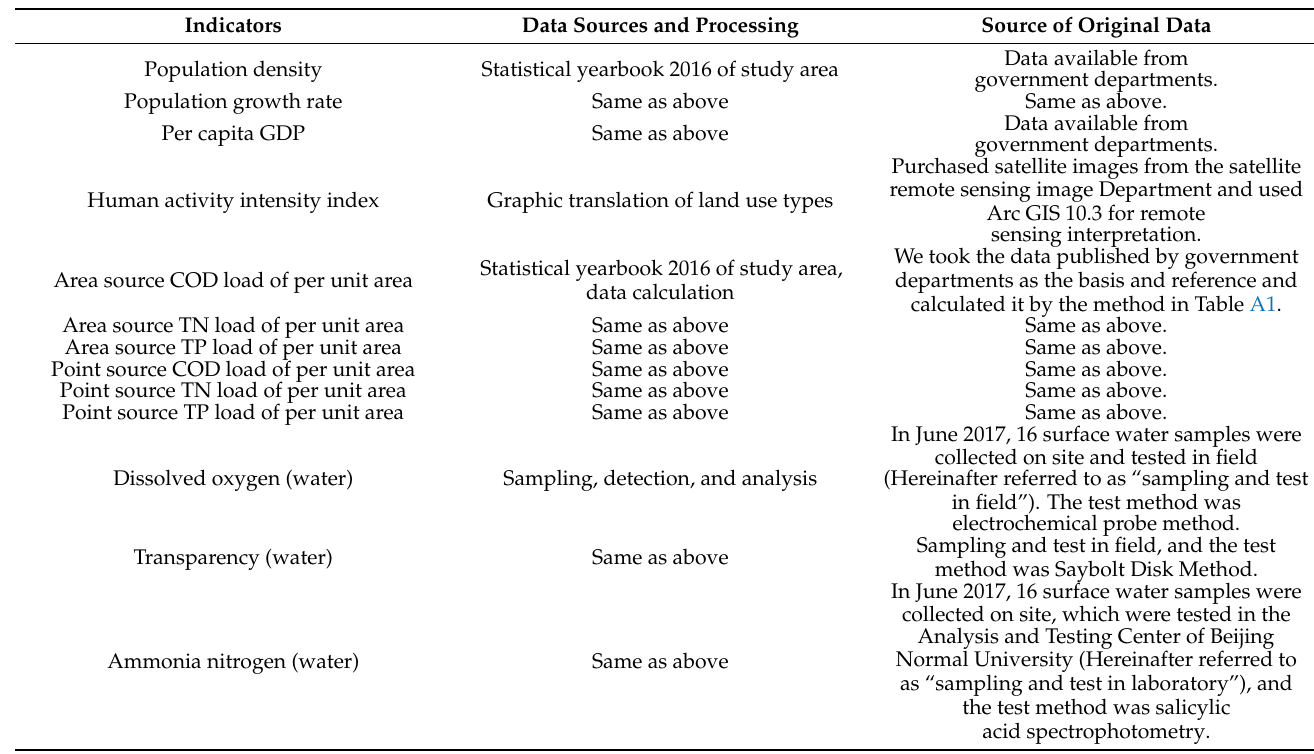
Table A2. Data acquisition